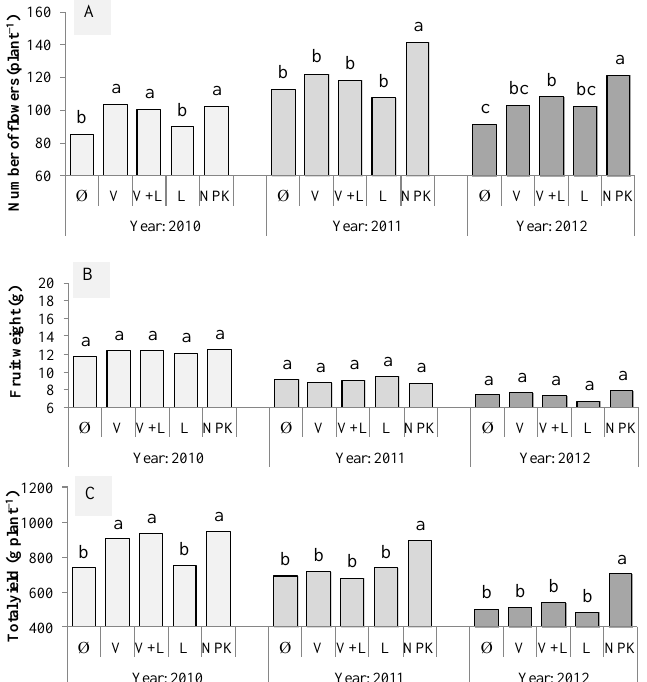
Figure 2. The total number of flowers ( A ), average strawberry fruit weight ( B ), and total yield of strawberries ( C ). Ø, control; V, vermicompost; V + L, vermicompost + leachate; L, leachate; NPK, mineral fertilizer. Different letters denote a significant difference at p < 0.05 for each year sepa- rately.